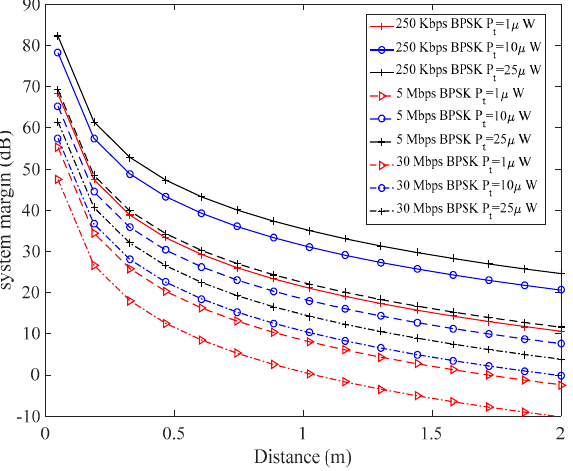
Figure 9. Link margin versus distance for 16QAM at multiple levels of data rates and powers.